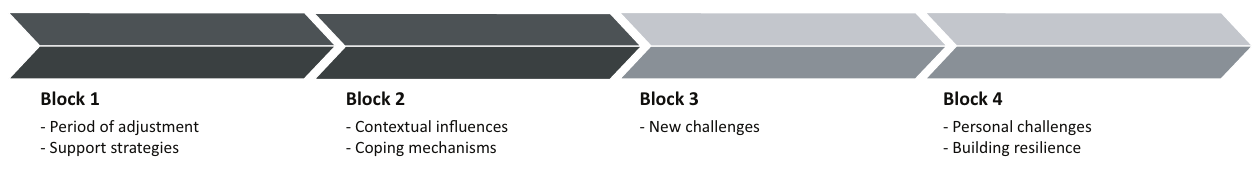
FIGURE 2: The themes per block for the academic year of